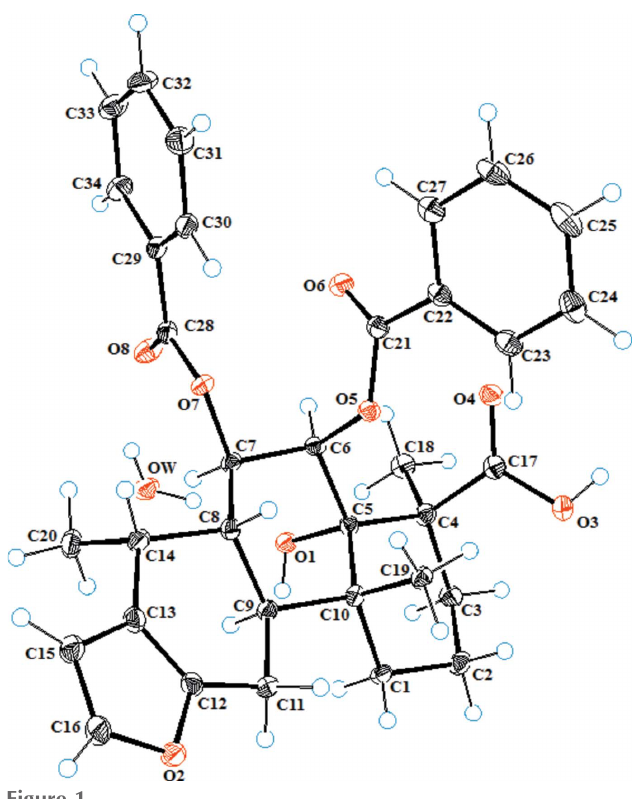
(Table 1) forms a ring with an S (7) graph-set motif.